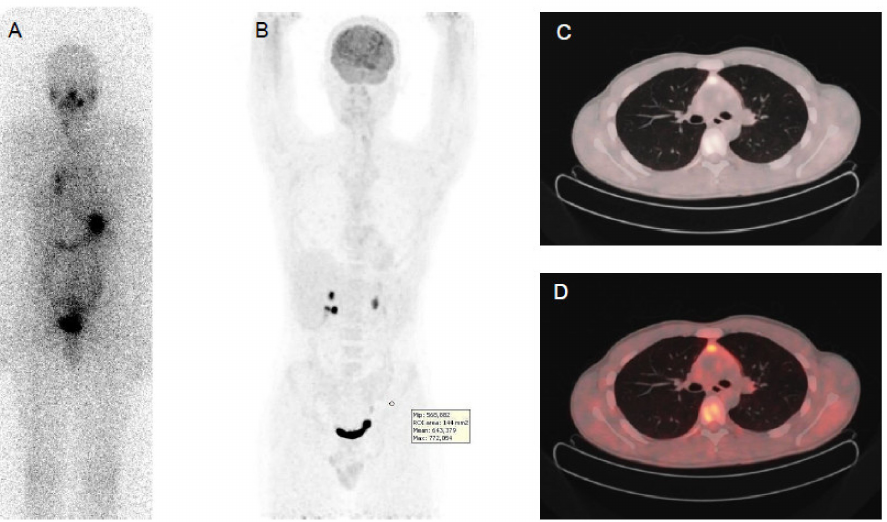
Figure 1. Papillary thyroid cancer in a 41-year-old man with a high thyroid stimulating hormone stimulated serum thyroglobulin level (475 ng/mL). Post-therapy ( A ) 131 I whole-body scan showed pulmonary uptake and uptake and in neck lymph nodes. 18 F-FDG PET-CT ( B,C,D ): CT images evidenced multiple small millimetric lung metastases ( B,C,D ), without significant 18 F-FDG uptake.